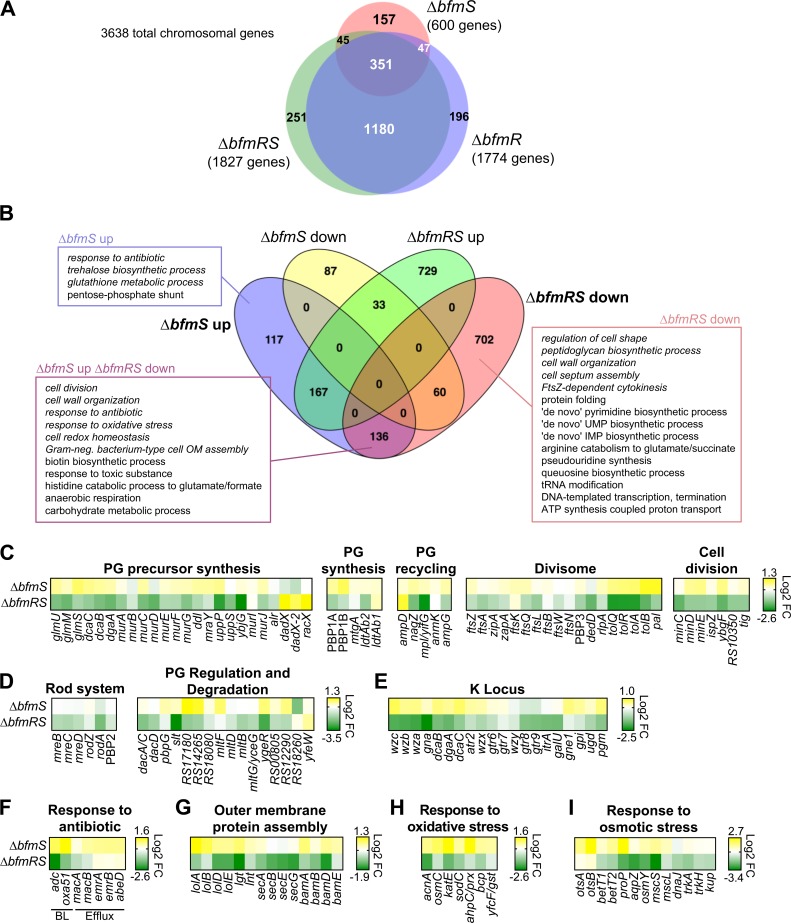
BfmRS globally reprograms the A. baumannii transcriptome.(A) Venn diagram showing differentially expressed chromosomal genes in each mutant [EGA195 (ΔbfmS), EGA496 (ΔbfmR), or EGA495 (ΔbfmRS)] vs WT. The A. baumannii chromosome contains 3638 total genes. Differential expression was determined by pairwise comparison of RNAseq data between each mutant and WT, requiring a q value < 0.05 to define a significant change. (B) Gene ontology (GO)-term enrichment analysis of genes differentially expressed due to bfmRS mutations. The Venn diagram depicts differentially expressed chromosomal genes whose up- or down-regulation is unique or common to different bfmRS alleles. GO biological process terms that were enriched in each category are indicated. Enriched terms required at least 2 genes in the differentially expressed gene subset, >2-fold increase in frequency in the differentially expressed gene set vs the entire genome, and a q value < 0.05. Enriched terms from only ΔbfmS-up, ΔbfmRS-down, and ΔbfmS-up ΔbfmRS-down gene subsets are shown. OM, outer membrane. (C-I) Heat maps showing bfmRS-dependent differential expression of genes in functional categories related to envelope synthesis and stress. Heat maps show log2 fold-change (FC) in transcription of each gene as determined by pairwise comparison of the indicated mutant vs WT via RNAseq. Grouping of genes in each pathway was determined by their associated GO terms and based on orthology with well-characterized E. coli proteins [21, 62, 63]. PG, peptidoglycan; BL, β-lactamases.